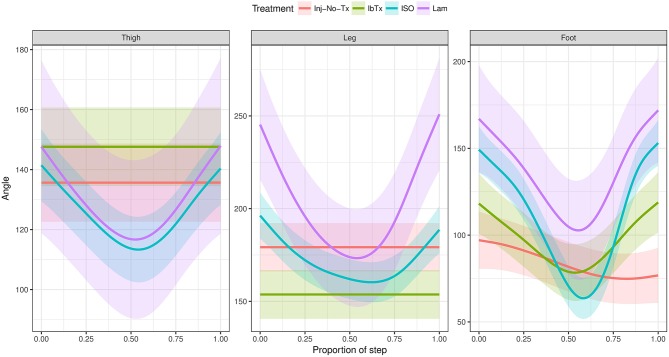
Generalized Additive Mixed Model of joint segment angles through a step cycle. The 2D gait analysis was used to calculate angles of the thigh, leg and foot segments through the proportion of the step cycle, and modeled using a GAM. Inj-No-Tx (red) and IbTx treated (green) animals demonstrated no swing phase in gait cycle in thigh and leg segment angles. Foot segment angles in the Inj-No-Tx and IbTx treated animals demonstrated some range of movement, although the mobility was less than in LAM (purple) and ISO (blue) treated animals. ISO treated animals demonstrated a classic swing phase in thigh, leg, and foot segment angles through the proportion of the step cycle, mirroring the LAM animals.